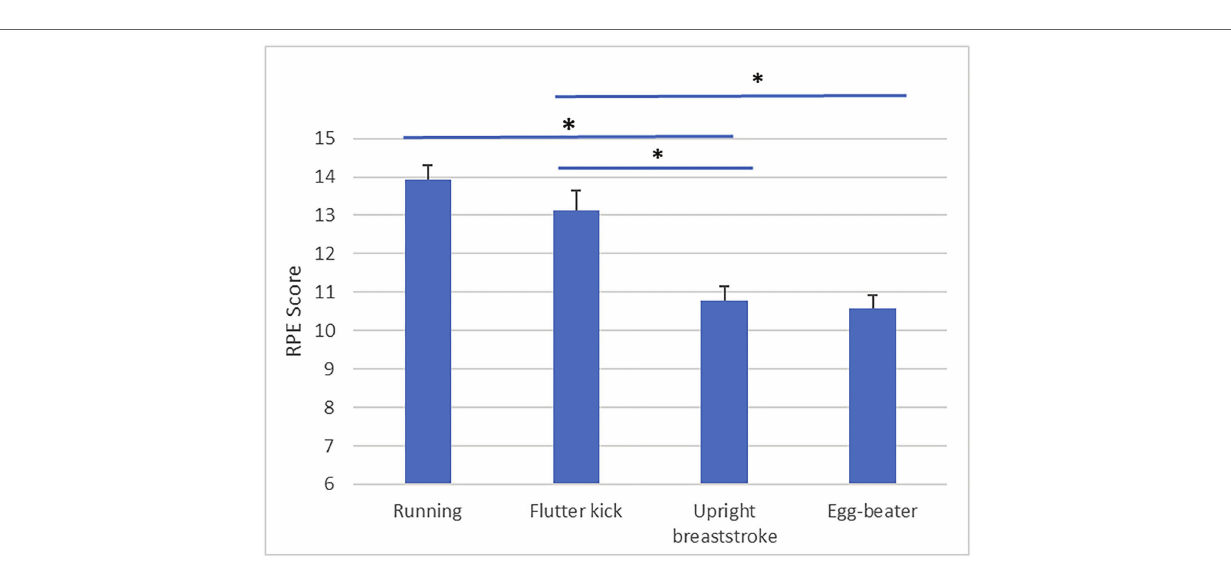
FIGURE 3 | Rate of Perceived Exertion (RPE) during four treading water techniques in experts – means and SEs. * Denotes significant difference between techniques ( p corrected <